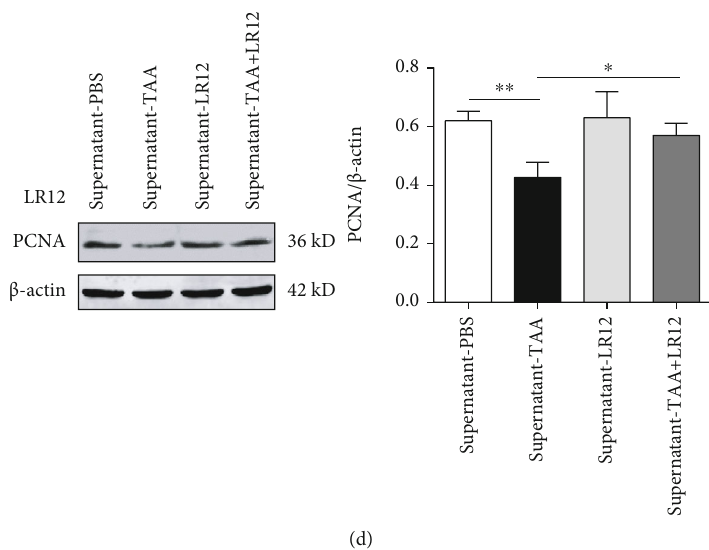
Figure 4: LR12 promoted primary hepatocyte proliferation via macrophages. (a) Primary hepatocytes and macrophages were extracted. (b) Immuno fl uorescence images of F4/80 staining and DAPI in primary macrophages. (c) CLSM showing CK18 and PCNA staining in primary hepatocytes stimulated with the primary macrophage supernatant. (d) Western blot analysis of PCNA in primary hepatocytes stimulated with the primary macrophage supernatant. Data were presented as the mean ± standard deviation (SD). ∗ P < 0 : 05 , ∗∗ P < 0 : 01 , and ∗∗∗ P < 0 : 001 versus control